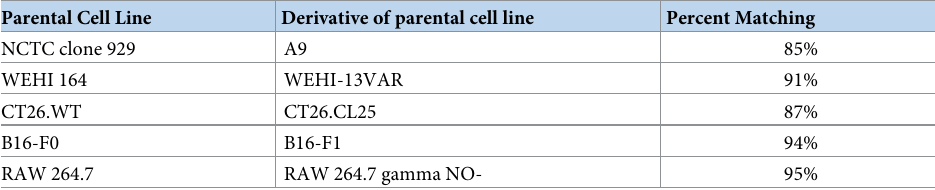
Table 8. Percent matching of known related cell lines using Master’s